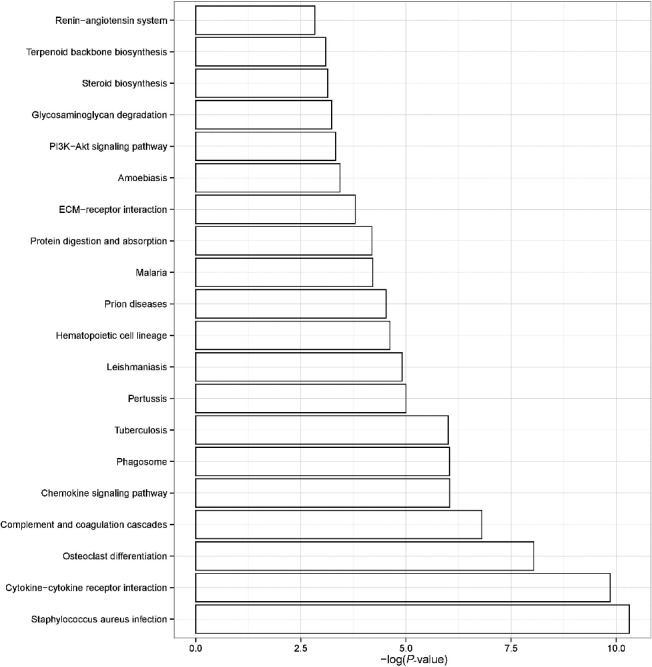
KEGG pathway enrichment analysis. The KEGG pathway analysis demonstrated that the “Staphylococcus aureus infection”, “Cytokine−cytokine receptor interaction” and “Osteoclast differentiation” were the most enriched pathways containing DEGs. The enrichment factors of the pathway are shown on the x-axis.